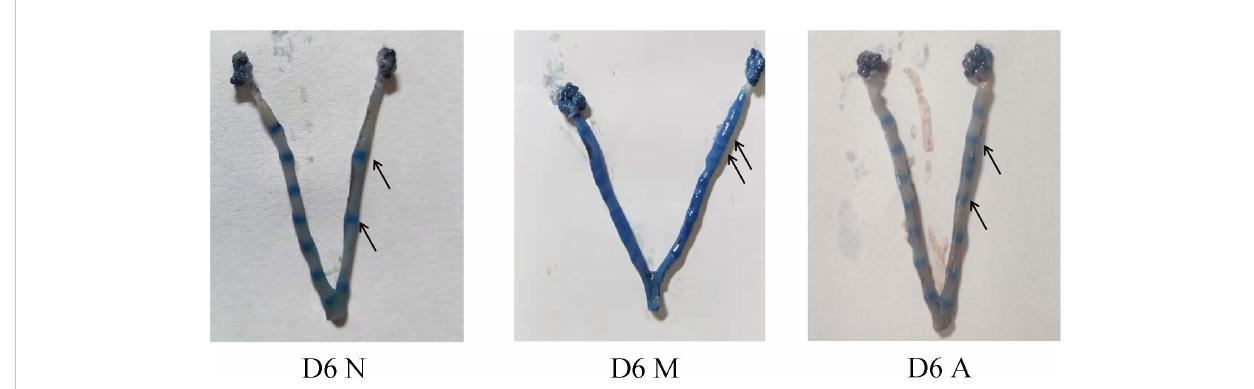
FIGURE 1 Uterus of embryo implantation in each group on D6. D, The embryo day; D6N, D6 normal group; D6M, D6 model group; D6A, D6 acupuncture